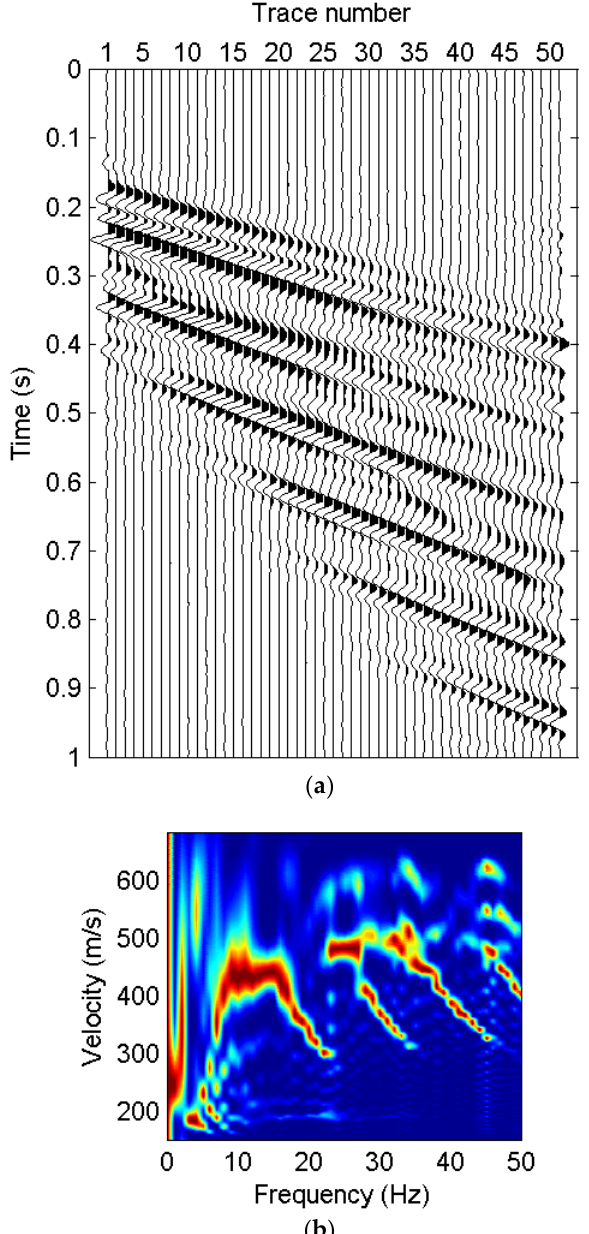
Figure 7. ( a ) The result of surface-wave separation by a two-dimensional (2D) window of the f-v domain and ( b ) its image of dispersive energy in the f-v domain.